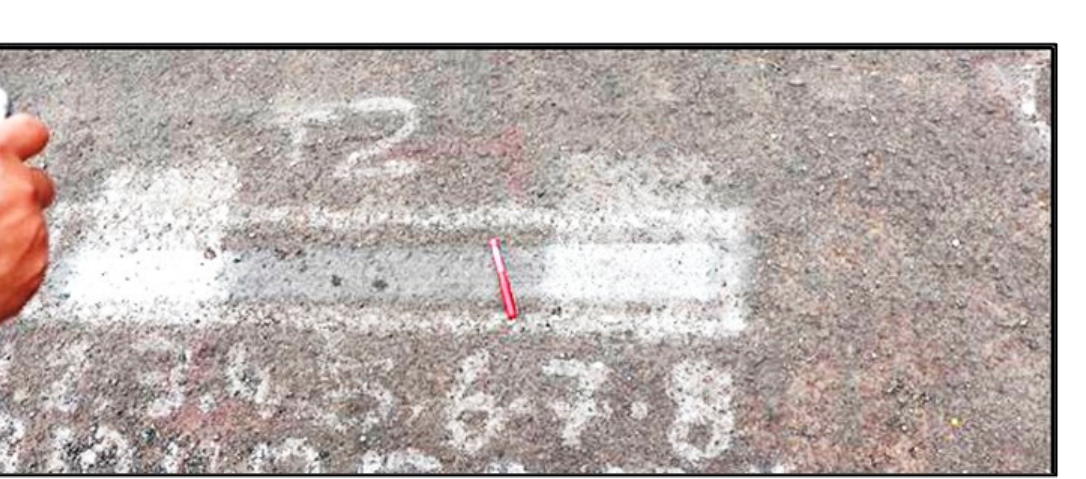
Figure 13. Condition of the Cape seal after APT at <20 °C.